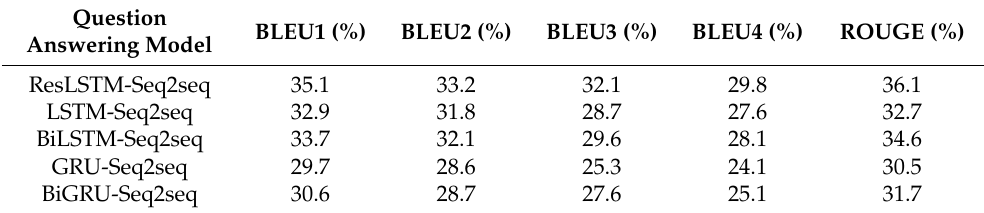
Table 5. BLEU and ROUGE comparison of different deep learning Q&A